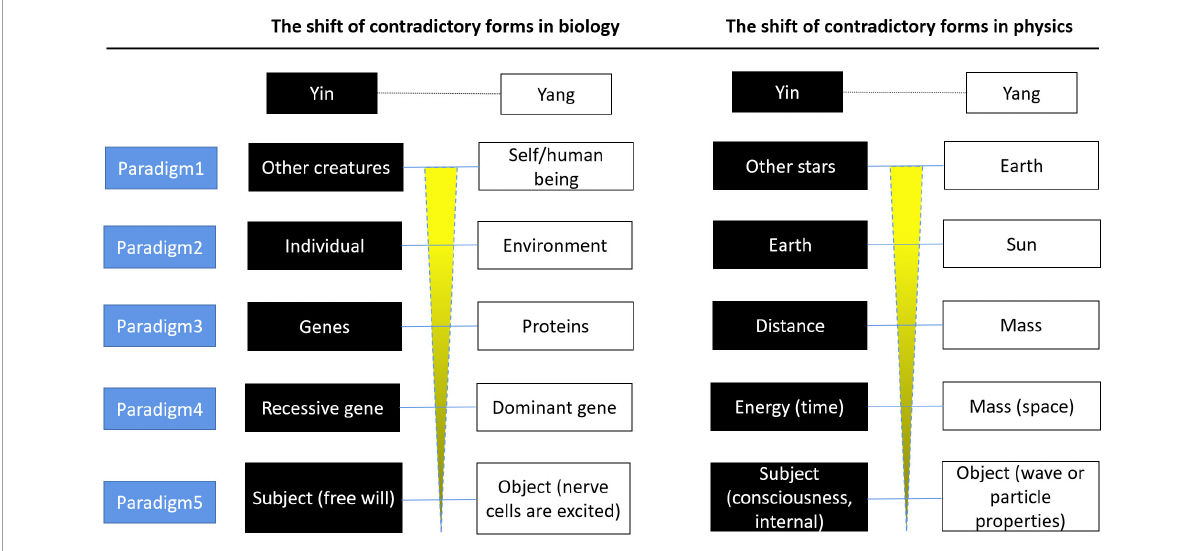
FIGURE4 Contradiction forms of paradigm in different stages are from obvious to hidden, from intuitive to basic in terms of perception. Objects in completely different physical forms (For example, genes and the earth) can be reduced to two contradictory (Yin-Yang) perceptual states. Yin: shows characteristics in perception like abstract, internal, hidden, defensive, passive etc.; and Yang: On the other hand, shows characteristics in perception like concrete, external, prominent, aggressive, positive etc. On the contrary, in order of precedence, Yin is in front and Yang is behind (Yin-Yang instead of Yang-Yin). For example, the exterior of a tree comes from hidden roots. Genes are the determinants of heredity, not proteins. Therefore, the causal view of holistic philosophy is internal, and the material view seeks external cause and effect. Paradigm l: In the most intuitive state of perception, according to external physical form, human beings are the most advanced creatures in nature and are very special beings. Thus, the self/human has core status (exhibiting abstract features of “Yang”) relative to the other creatures, while other creatures are relatively insignificant (exhibiting abstract features of "Yin"); the other stars revolve around the earth and are therefore passive and active relationship (Yin and Yang, respectively). Paradigm 2: The theory of natural selection suggests that the individual needs to adapt to the environment, so the individual is in a passive status (Yin) and the environment is in an active status (Yang); the heliocentric theory proposes that the earth revolves around the sun, so the sun is active (Yang) and the earth is passive (Yin). Paradigm 3: Genes are the internal determinants of biological traits (Yin) with hidden characteristics, while external traits are mainly presented by proteins (Yang); two descriptors in the equation of universal gravitation, F = Gmlm 2 /r 2 . Mass (m) is perceived first and distance (r) second, so distance is Yin and mass is Yang (Just like a cup, the surrounding outer wall is focused by perception firstly, and the empty part inside is focused secondly, but the two together can hold water as a cup). Paradigm 4: Mendel proposed the most basic genetic law was based on dominant gene (A) and recessive gene (a). The recessive gene (Yin) was in a hidden status compared with the dominant gene (Yang); in the theory of relativity (E = mc 2 ), the relationship between two fundamental descriptors, mass exhibits concrete characteristics (Yang), while energy is an abstract state (Yin). Paradigm 5: Matter exhibits remarkable and concrete characteristics (Yang), consciousness is abstract and hidden (Yin), you can’t see it but you can feel it. Both physics and biology reveal an inseparable relationship between matter and consciousness or subject and object. It should be emphasized that this empirical division of Yin and Yang according to experience and perception is not absolute. For example, in rare cases, proteins can also serve as genetic material, reflecting a mutually inclusive relationship between